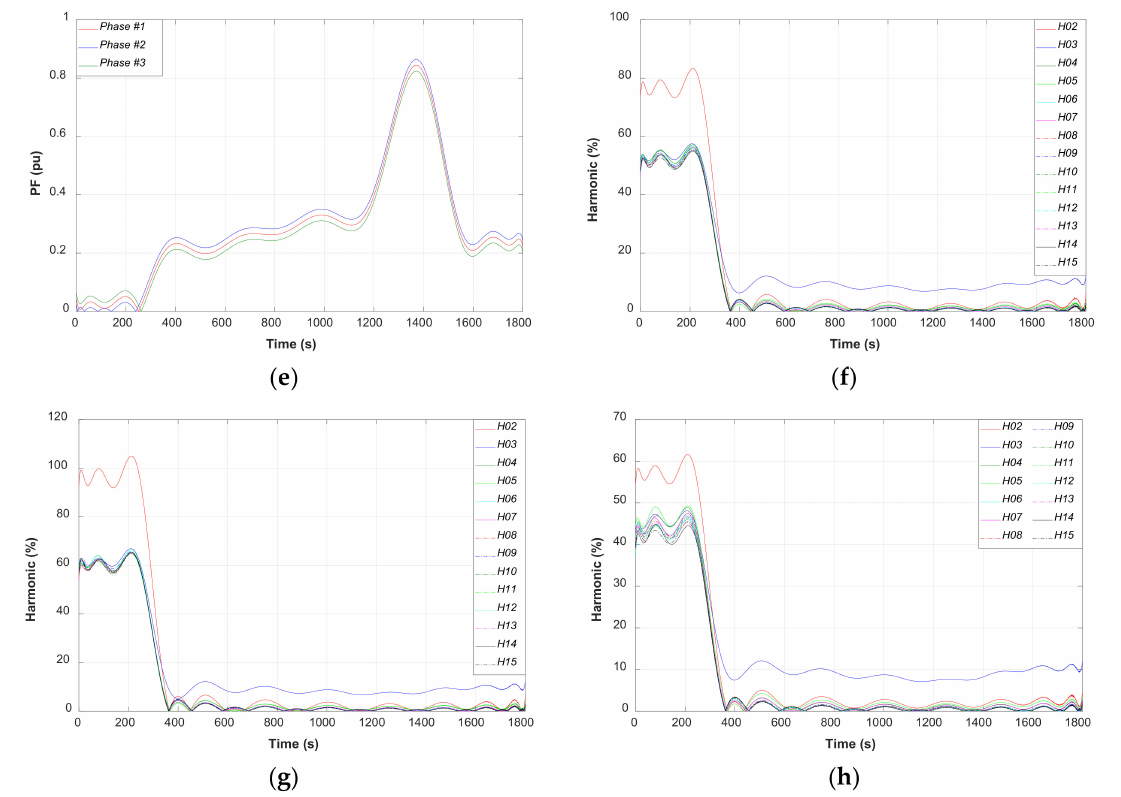
Figure 16. Measured data per phase for a synchronous generator feeding a three-phase asynchronous motor with a wound rotor: ( a ) voltages; ( b ) currents; ( c ) active powers; ( d ) reactive powers; ( e ) power factor; ( f ) Phase #1 current harmonics; ( g ) Phase #2 current harmonics; and ( h ) Phase #3 current